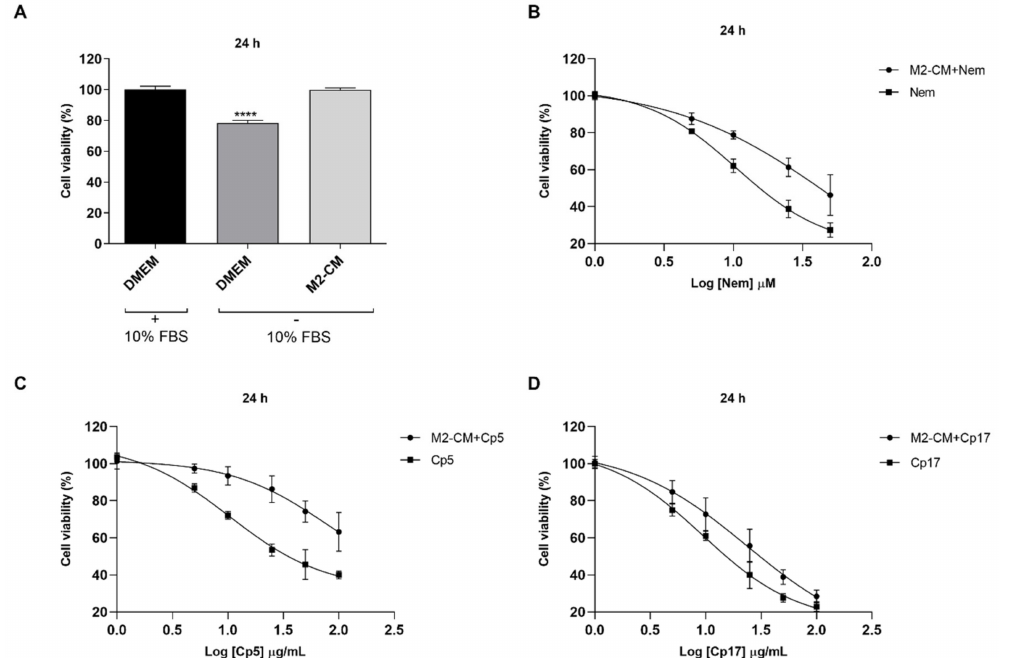
Figure 4. E ff ect of M2-conditioned medium (M2-CM) on HT-29 cell viability for 24 h. ( A ) HT-29 cells were exposed to DMEM (10% FBS), DMEM (FBS free) and M2-CM to evaluate cell viability; ( B – D ) HT-29 cells were exposed to M2-CM with / without increasing concentrations of Nem ( B ), Cp5 ( C ), Cp17 ( D ). Data reported as the mean ± SD of three independent experiments. **** p < 0.0001 vs. DMEM (10%